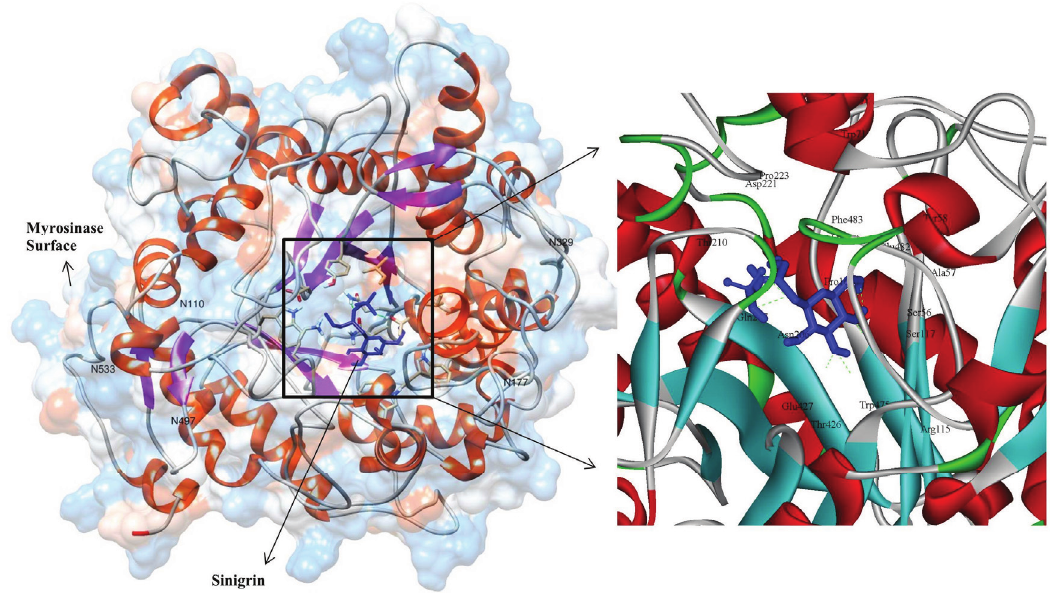
Figure 5. Graphical illustration of docked complex of myrosinase protein with sinigrin and potential N -glycosylation sites were highlighted. The 2D plot of interaction results were denoted as in black color (interacted amino acids), dotted green lines (hydrogen bonds) and blue color